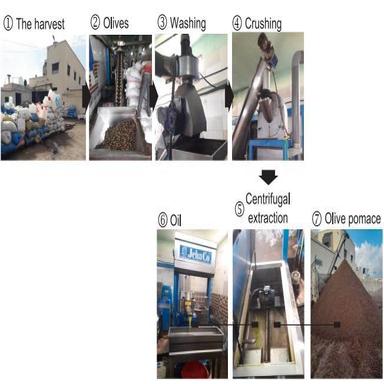
The treatment of the olive and the waste produced.